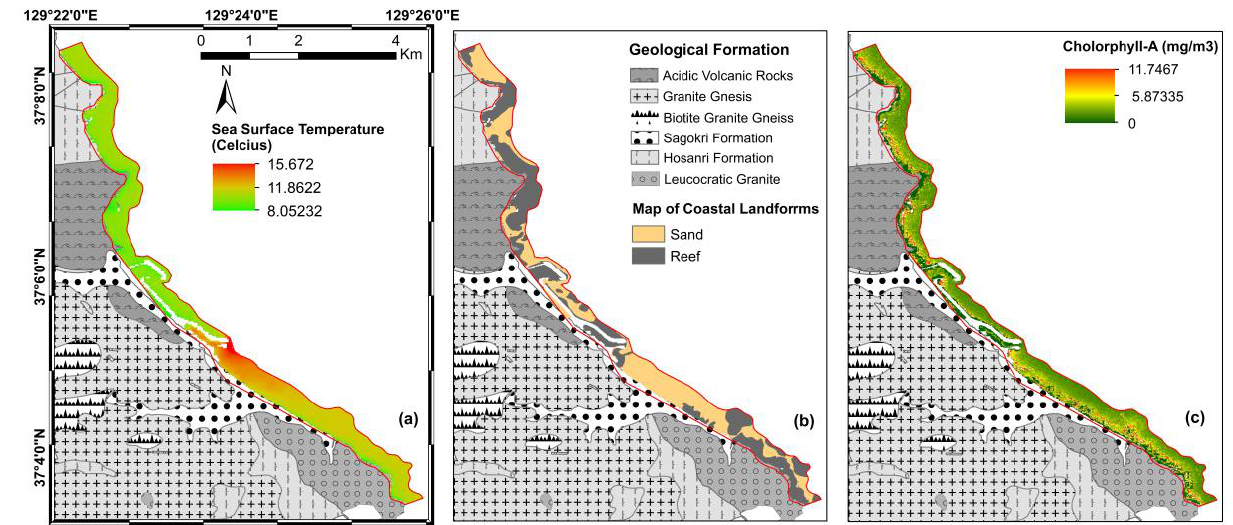
Figure 4. Oceanography conditions mapping ( a ) sea surface temperature distribution ( b ) map of coastal landforms along Uljin-gun ( c ) chlorophyll-a distribution .